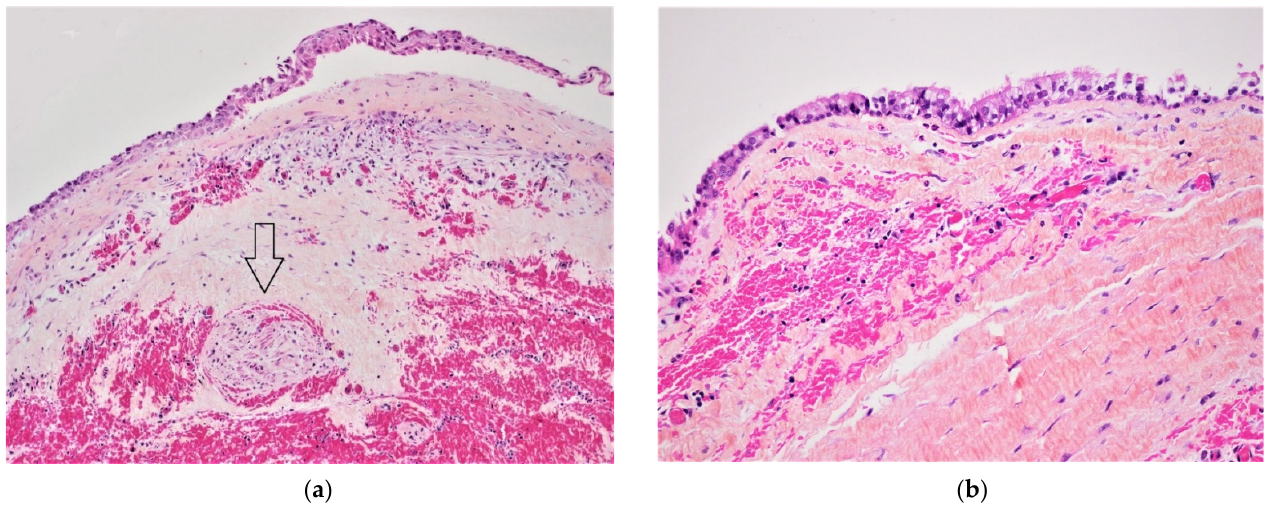
Figure 4. Histopathological examination of the excised specimen showing stratified squamous, cuboidal and ciliated respiratory epithelium (hematoxylin and eosin stain at ( a ) 20× and ( b ) 40× magnification. The arrow in ( a ) indicates a large nerve bundle.